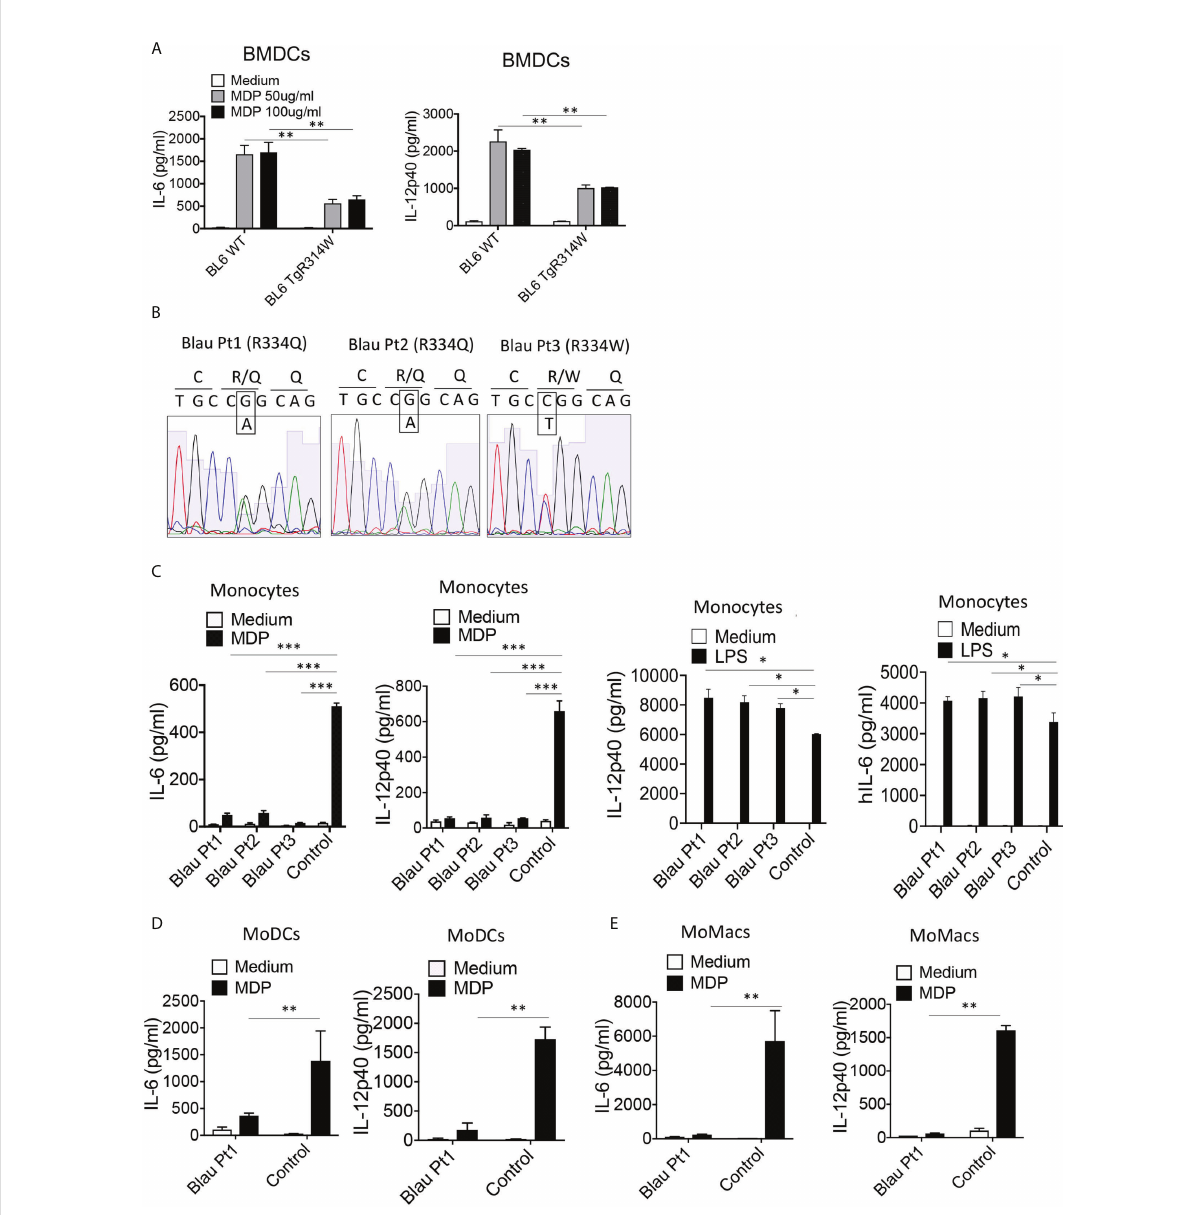
FIGURE 5 The BS-NOD2 Transgene Exerts a Dominant Negative Effect on Cellular Responses. (A) Bone marrow derived dendritic cells (BMDC) from WT (C57BL/6) mice, or C57BL/6 mice expressing a transgene bearing a Blau (R314W) mutation (BL6TgR314W) were stimulated with the indicated doses of MDP for 24 hrs after which the cell culture supernatants were subjected to ELISA analysis of IL-12p40 and IL-6 secretion. (B) Total mRNA was extracted from PBMCs of three patients with Blau syndrome (Pt1, Pt2 and Pt3). The RNA samples were reverse transcribed to cDNA and subjected to PCR to amplify human NOD2 sequence. The ampli fi ed NOD2 sequence was subjected to sequencing. (C) Monocytes isolated from PBMCs of three patients with Blau syndrome (Pt1 and Pt2, carrying R334Q mutation in one allele; Pt3, carrying R334W mutation in one allele of NOD2) and three control individuals were stimulated with MDP (50 m g/ml) or LPS (200 ng/ml) for 24 hours after which the cell culture supernatants were subjected to ELISA assay of IL-12p40 and IL-6 secretion. (D, E) Monocytes from a Blau patient and a control individual were differentiated into dendritic cells (MoDC, D ) or macrophages (MoMac, E ), the cells were then stimulated with MDP (50 m g/ml) for 24 hours after which the cell culture supernatants subjected to ELISA assay of IL-6 and IL-12p40 secretion. Data were analyzed using a two-way ANOVA with Tukey ’ s multiple comparisons and are displayed as mean ± SEM;. *p<0.05; **p<0.01;